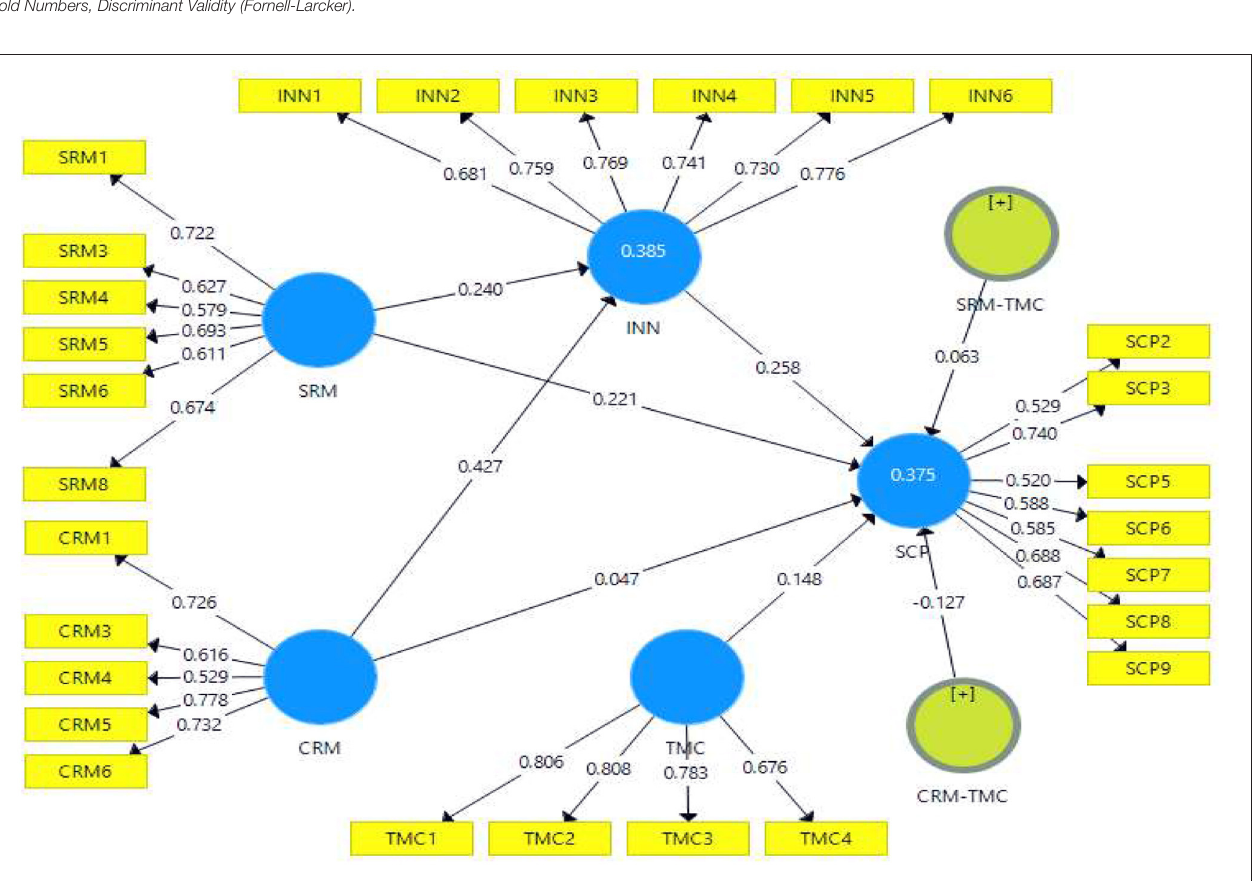
FIGURE 3 | Measurement